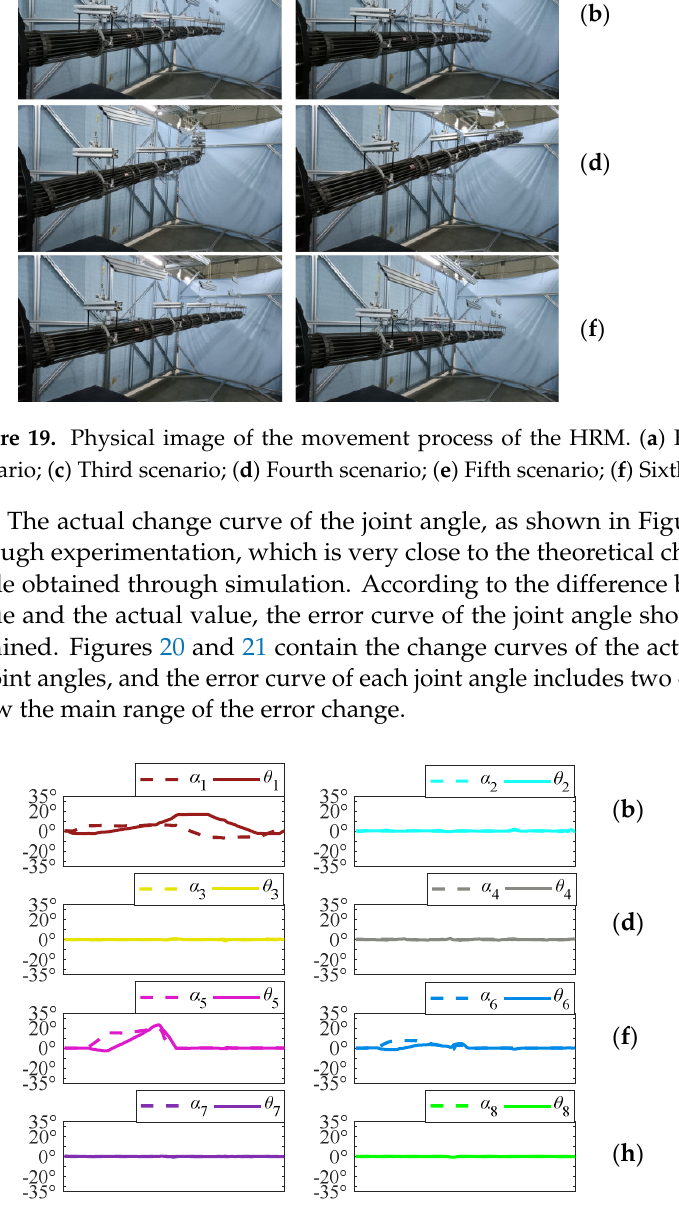
Figure 20. Diagram of the actual changes in joint angles in the non−repeating path experiment. ( a ) Angular change curve at 1st joint; ( b ) Angular change curve at 2nd joint; ( c ) Angular change curve at 3rd joint; ( d ) Angular change curve at 4th joint; ( e ) Angular change curve at 5th joint; ( f ) Angular change curve at 6th joint; ( g ) Angular change curve at 7th joint; ( h ) Angular change curve at 8th joint.